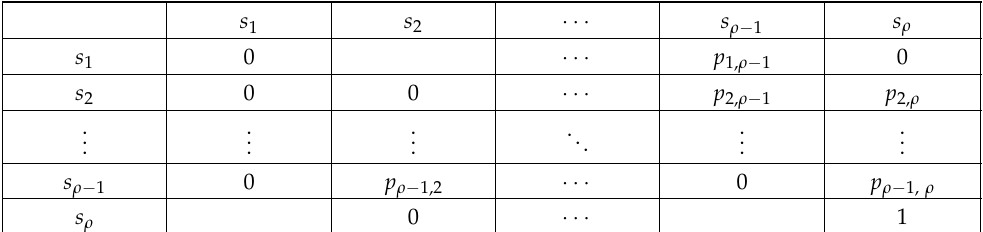
Table 1. Typical matrix of transition probabilities used in this process. Source: Authors’ own elaboration. s 1 s 2 · · · s ρ − 1 s ρ s 1 0 · · · p 1, ρ − 1 0 s 2 0 0 · · · p 2, ρ − 1 p 2, ρ . . . . . . . . ... . . . . . . . s ρ − 1 0 p ρ − 1,2 · · · 0 p ρ − 1, ρ s ρ 0 · · ·